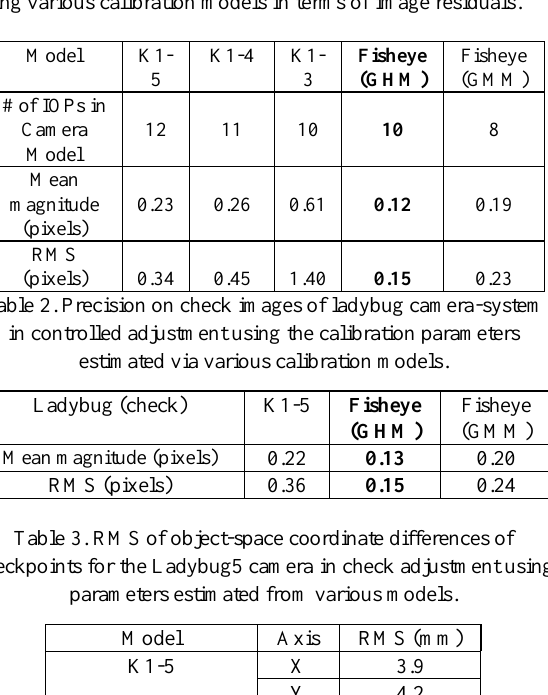
Table 1. Calibration precision of Ladybug5 camera system using various calibration models in terms of image residuals.